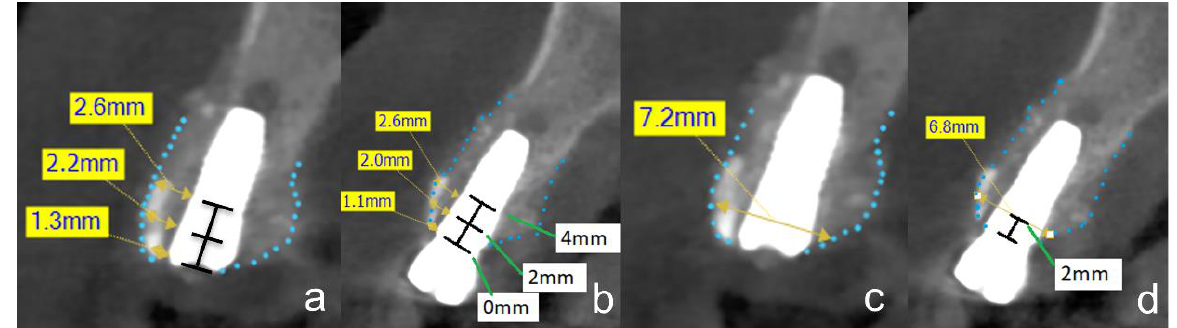
Figure 4. CBCT at time of implant insertion ( a , c ) and three months after implant insertion, at the time of implant exposure ( b , d ). The dotted lines outline the alveolar ridge. The images show the same case with the respective measurement methods. ( a , b ): The assessment and measurement of the buccal lamella are shown in this figure. The tooth shell is visible in the vestibular area. The thickness of the buccal lamella was measured at three different levels (L0 = 0 mm, L2 = 2 mm, and L4 = 4 mm). ( c , d ): The bucco-oral alveolar ridge width was also measured in the sagittal plane. The measurement was carried out at level L2. In this case, the width was 6.8 mm.